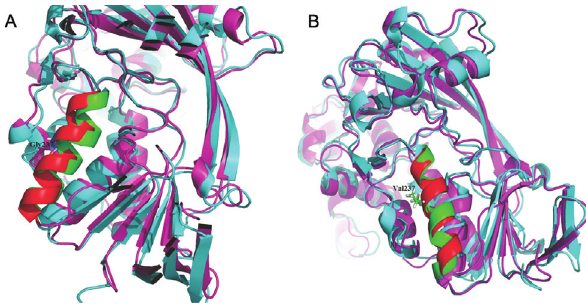
Figure 3 - The 237 mutation. (A) The 237 residue located helix of the wild type (cid:6) GDI exhibited a distinct conformational change after a 50 ns molec- ular dynamics simulation. (B) The conformation of this helix of 237 mu- tant (cid:6) GDI showed relative stability vs. the wild type. The red color repre- sents the initial conformation of 237 residue located helix of both wild type and 237 mutant (cid:6) GDI, and green indicates the ones simulated by mo- lecular